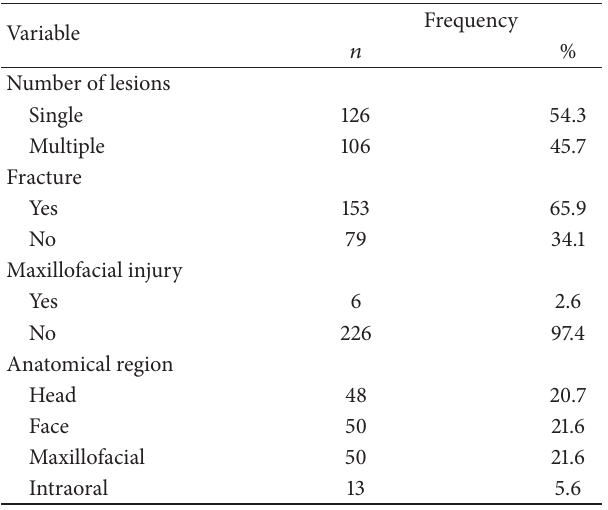
Table 2: Distribution of victims according to the number of lesions, existence of fracture, maxillofacial injury, and anatomical region involved in Campina Grande,